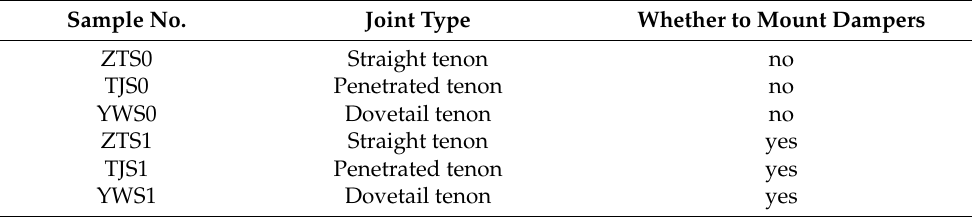
Figure 2. Detailed dimensions of tenon and mortise joints sample (unit: mm): ( a ) Straight tenon; ( b ) Penetrated tenon; ( c ) Dovetail tenon.